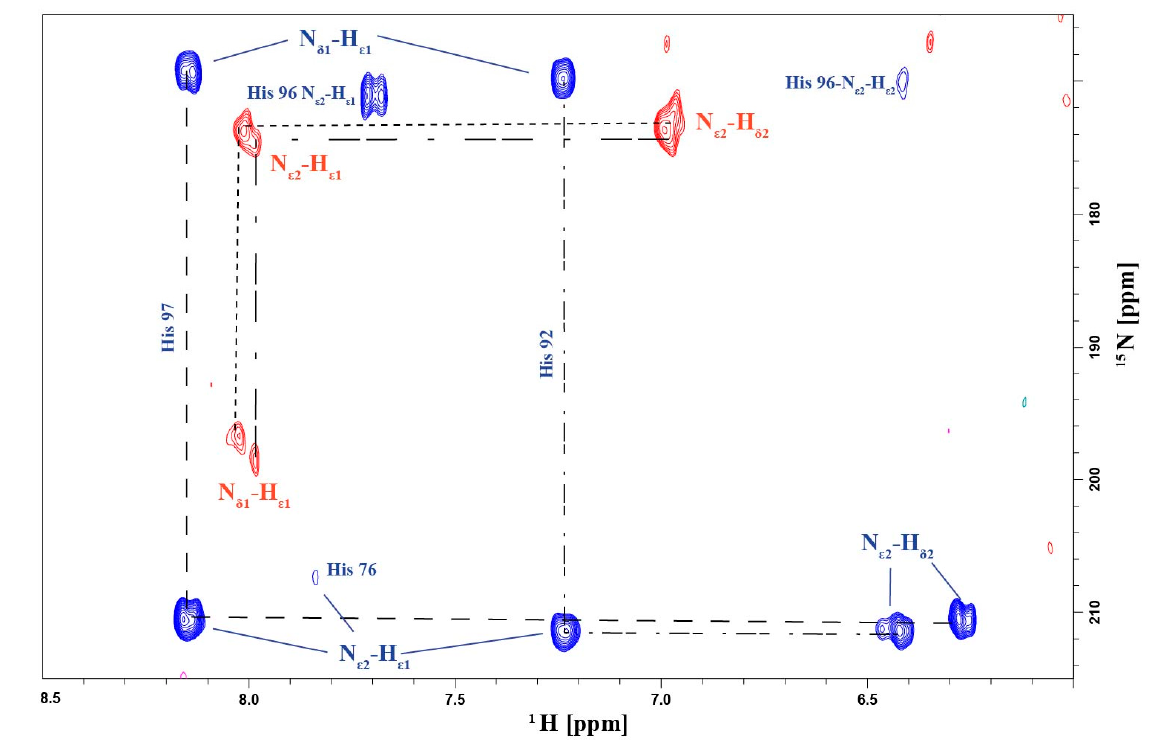
Figure 6. The 1 H- 15 N-HSQC spectrum in which only HN/N two-bond correlations are reported for Cu(I) Ros-87 (red) and Zn-Ros87 (blue).